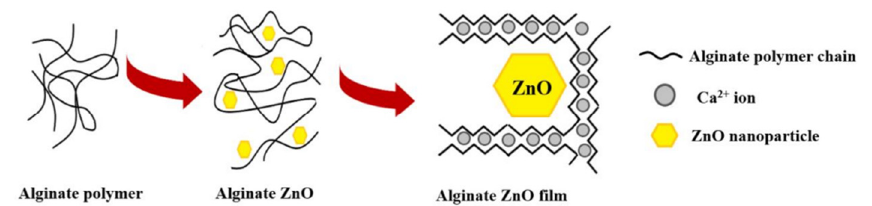
Figure 7. Schematic representation of alginate films with ZnONPs. Reprinted with permission from ref [182], MDPI, 2022.